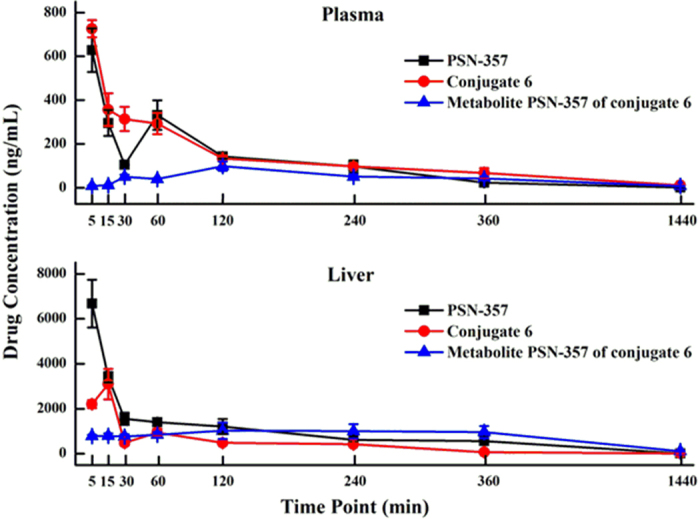
The drug concentration-time curve in the plasma and liver (ng/mL) after intravenous administration of PSN-357 and conjugate 6 in mice (n = 3).